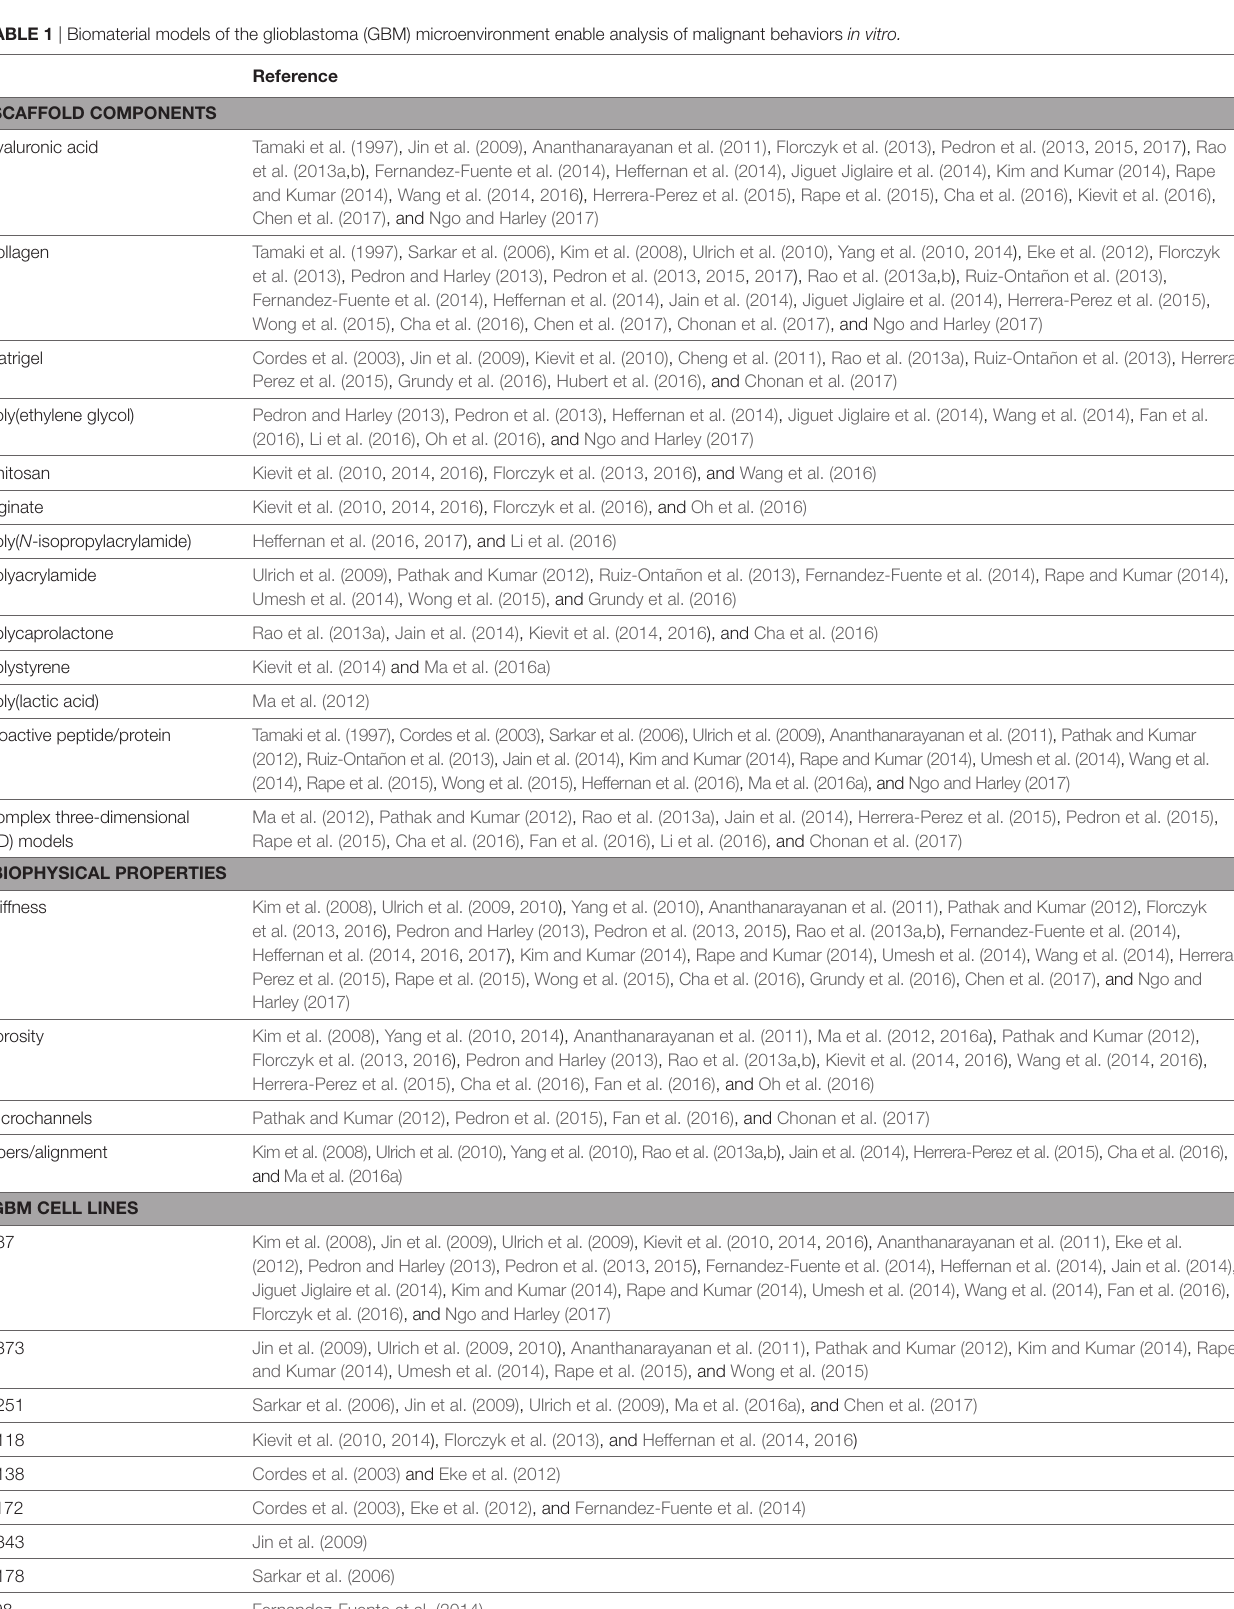
TABLe 1 | Biomaterial models of the glioblastoma (GBM) microenvironment enable analysis of malignant behaviors in vitro.